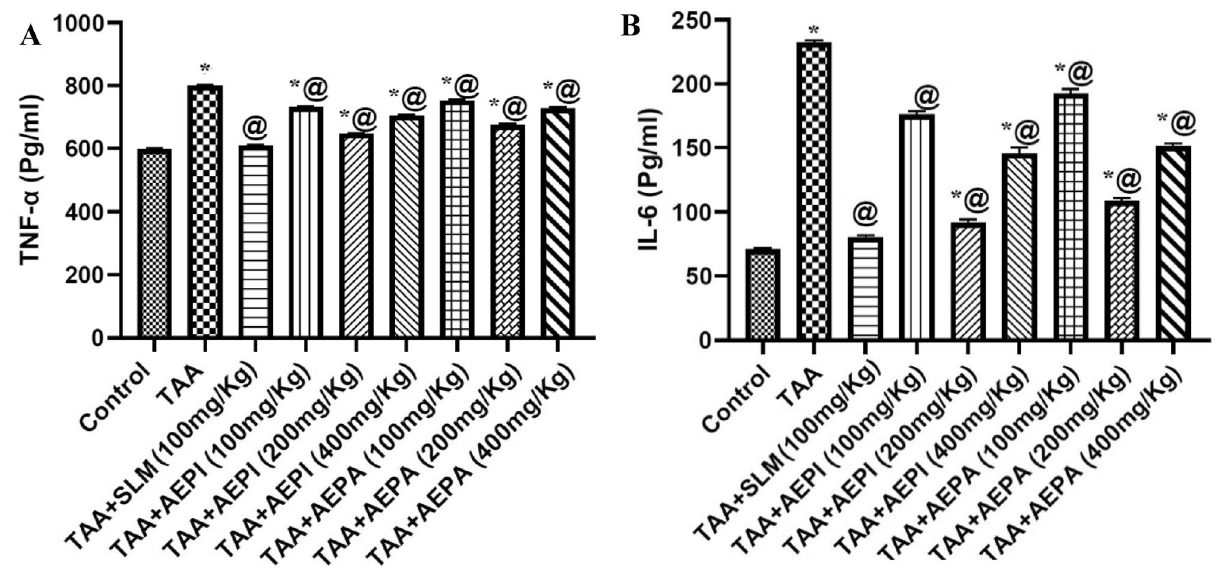
Figure 3. Effects of pretreatment with hydroalcoholic extracts of the aerial parts of P. indica or P. auriculata on the hepatic contents of inflammatory markers in TAA-induced injury in rats. ( A ) Tumor necrosis factor (TNF- α) and ( B ) interleukin (IL-6). Animals were given TAA (200 mg/kg/day; i.p.) on 14th and 15th days. Other regimens were given orally and daily for 15 days. Results were expressed as Mean ± SD, n = 5. SLM: Silymarin, * ,@ Significantly different from normal control and TAA groups at p < 0.05, respectively.